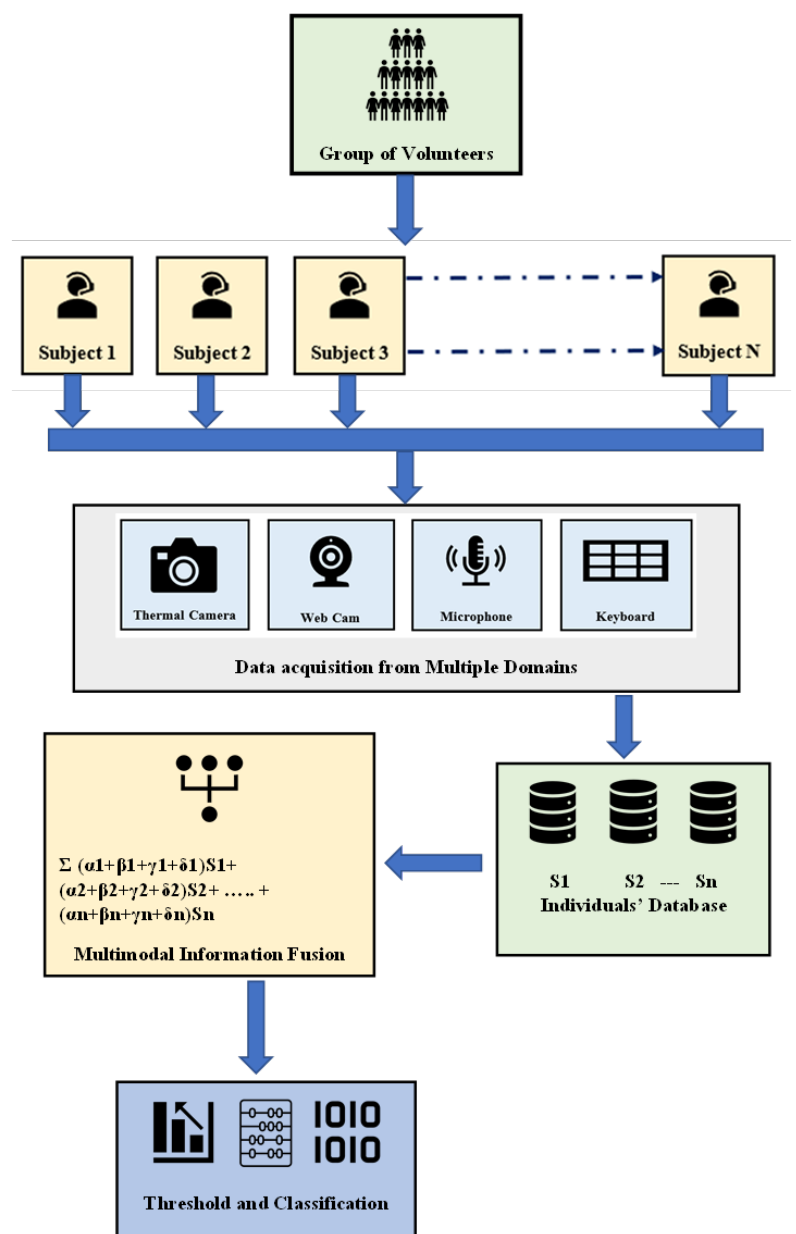
Figure 7. Exhibits methodology for fatigue detection using multimodal fusion. Table 6. Multimodal feature fusion classification